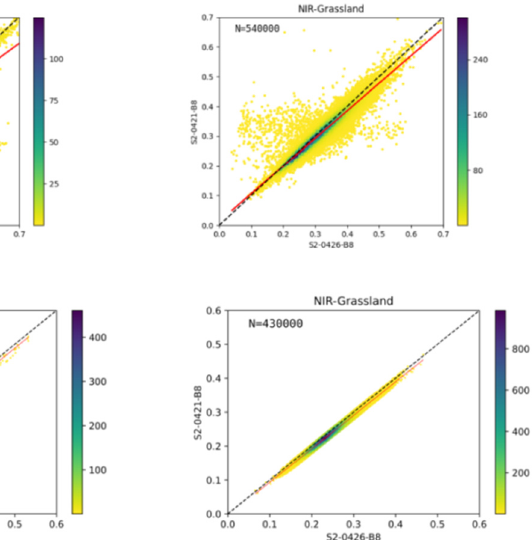
Figure 9. An example of the process of eliminating the erroneous pixels in a Sentinel-2 image. ( a ) Original image, where the pixels in the red frame are under the shadow of clouds; ( b ) experi- mental image, with no pixels in the red frame; ( c ) comparison image, where the pixels in the red frame are eliminated.